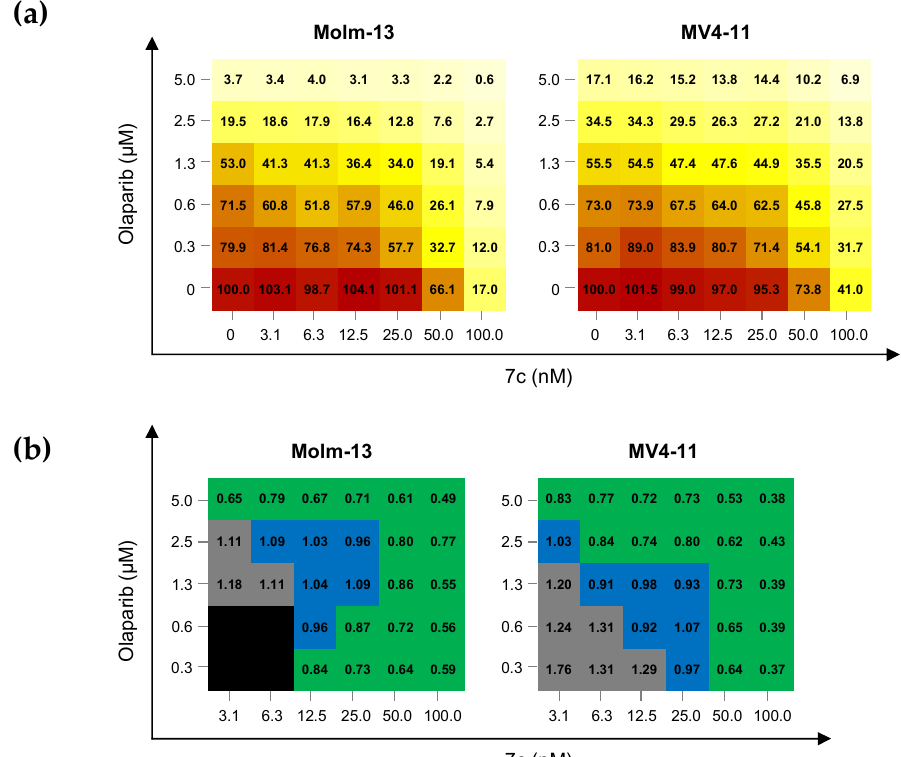
Figure 5. Combination treatment with compound 7c and olaparib synergistically inhibited cell growth. ( a ) Human FMS-like tyrosine kinase 3-internal tandem duplication-positive acute myeloid leukemia (FLT3-ITD + AML) cells (Molm-13 and MV4-11) were treated with 7c or olaparib or both at the indicated concentrations. Cell viability was determined using the CCK-8 assay 5 days post treatment. Relative viability is shown for each combination at the indicated concentrations. Data are from one representative experiment that had four replicates. ( b ) Combination index (CI) scores of 7c and olaparib combination at the indicated concentrations in Molm-13 and MV4-11 cells. Green, synergistic (CI < 0.9); blue, additive (1.1 ≥ CI ≥ 0.9); gray, antagonistic (CI > 1.1); black, non-significant. Each CI score represents average data derived from the indicated concentrations of single and combined compound treatments in four independent